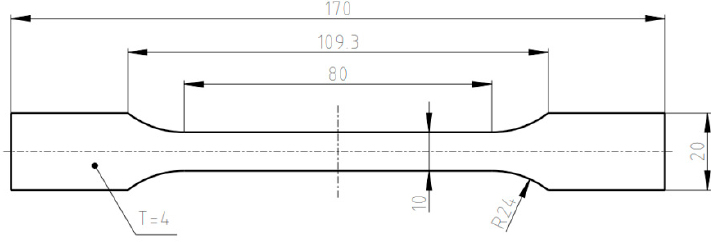
Figure 5. Sample dimensions for tensile test.